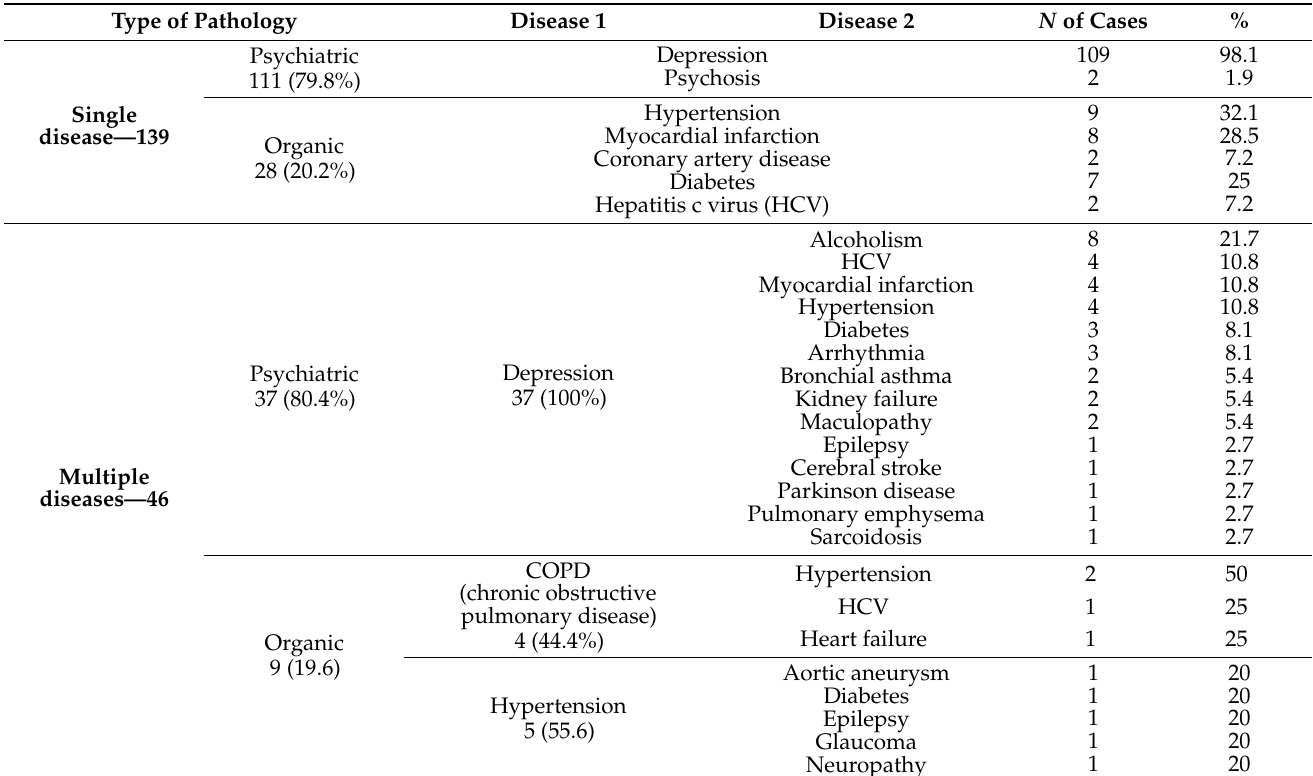
Table 2. Details of single and multiple disease affecting